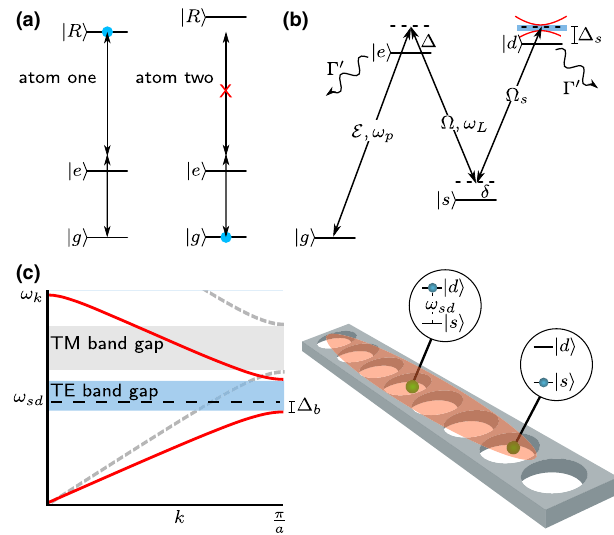
FIG. 1. (a) Rydberg interactions between atoms mediate photon-photon interactions. Two-photon excitation of atom 1 to Rydberg level R shifts the R level in other surrounding atoms by an amount much larger than the two-photon transition width, making the transition effectively two level for a second photon entering the system. (b) Four-level atom for EITwith interactions. The input quantum probe field E couples to the transition j g i − j e i , while transition j s i − j e i couples to a classical drive field. Adding level j d i that couples to the band edge modes of a photonic crystal (red curves with blue region indicating the band gap) and driving the transition j s i − j d i off-resonantly creates an effective interaction between atoms in state j s i . For simplicity, we assume states j e i and j d i both have a free-space spontaneous decay rate Γ 0 . (c) The periodic dielectric structure of a photonic crystal (right) leads to band structure (left) in the dispersion relation for photons propagating in the dielectric, where inter- ference leads to band gaps over which propagation is forbidden. For photonic crystals that support multiple modes, e.g., TE and TM (represented here by the solid and dotted lines), the band gaps of different modes may occur at different frequencies. The j s i − j d i transition of the atoms (green spheres) trapped near the photonic crystal couples to the photonic crystal bands. When the transition frequency ω is in the band gap (with detuning Δ sd b from the band edge) atoms can couple with one another via evanescent fields in the photonic crystal (illustrated in red), yielding a dipole-dipole interaction between the